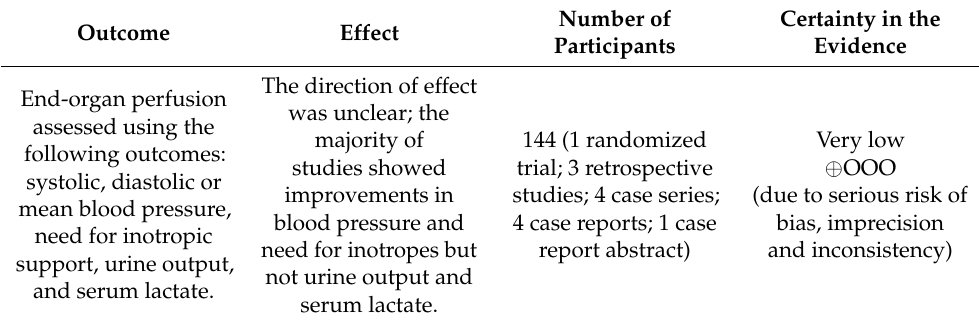
Table 4. Summary of